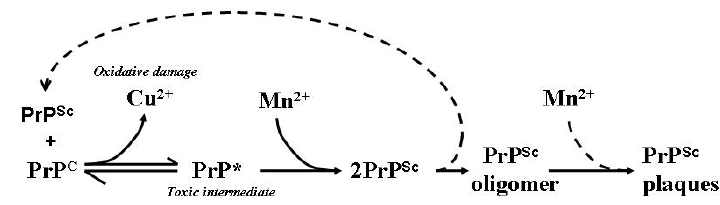
Figure 3. Model of the involvement of Mn in the generation of PrP Sc isoforms, aggregates and plaques. PrP Sc is able to influence the conformation of PrP C in a template-driven manner. This altered conformation of PrP C loses its affinity for Cu while increasing an affinity for Mn facilitating the stabilisation and accumulation of PrP Sc and the eventual formation of PrP plaques as aggregated protein dumps. Free Cu is able to participate in deleterious redox reactions which can generate free radicals capable of damaging cellular macromolecules such as lipid membranes, proteins and DNA. PrP* represents the proposed toxic intermediate; dotted lines represent assumed associated reactions